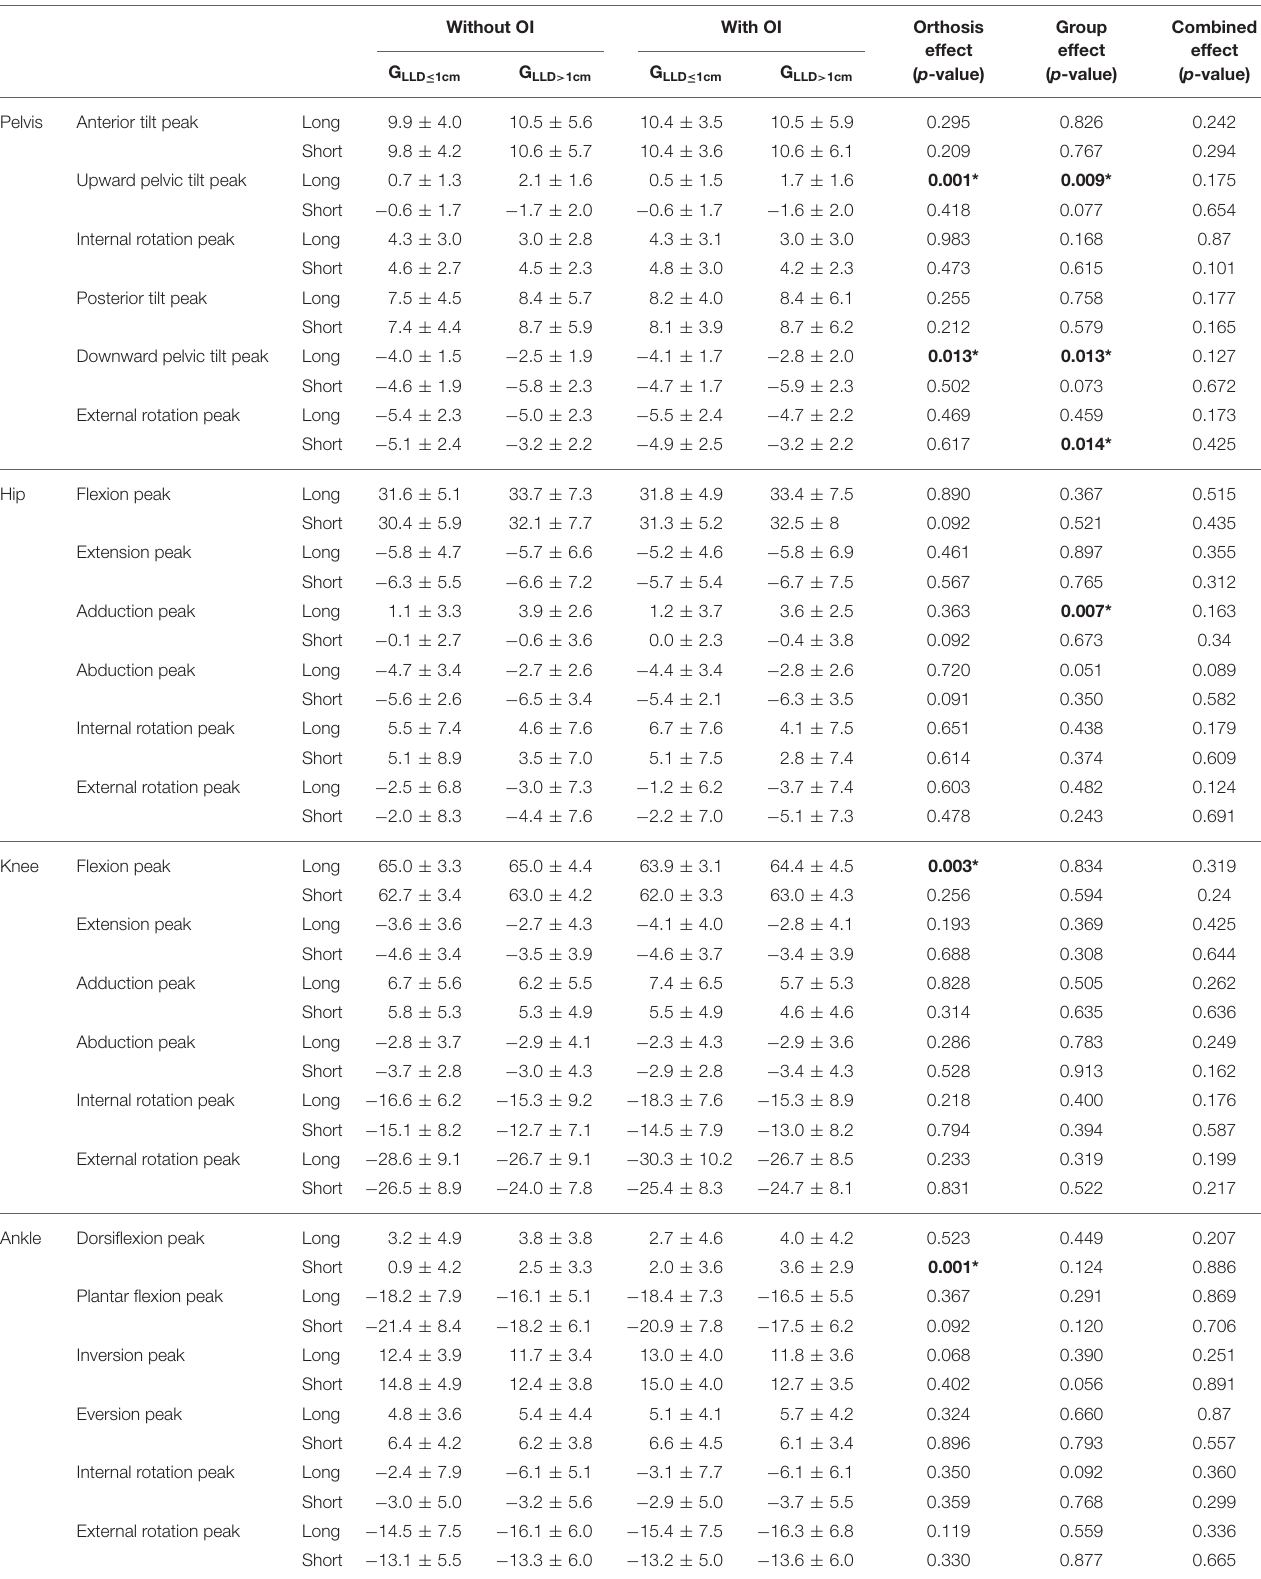
TABLE 4 | Peak swing phase angles of the pelvis, hip, knee, and ankle joints for each leg with and without orthotic insoles (OI) for both groups. Without OI With